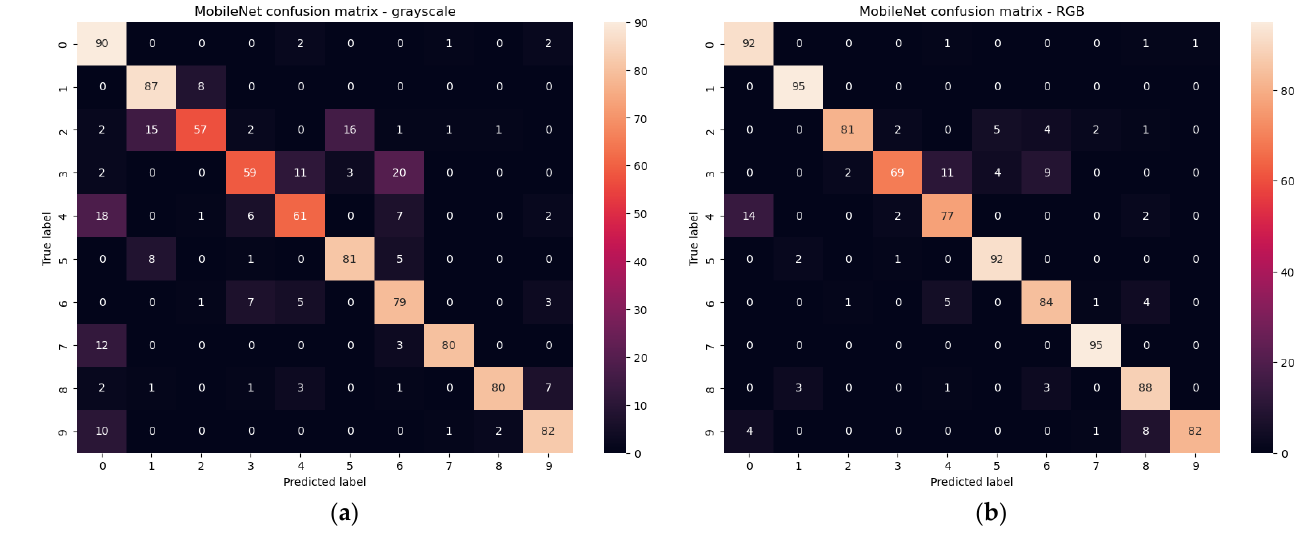
Figure 17. Confusion matrixes for test set of grayscale ( a ) and RGB ( b ) images for MobileNetV2. Table 3. 2D CNN classifiers